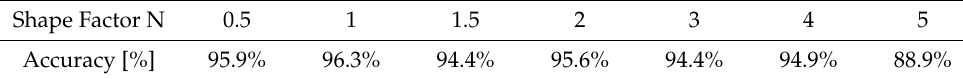
Table 6. Total accuracy for parameters for selected values of shape factor